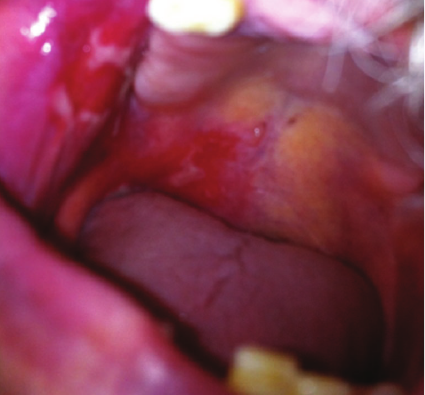
Figure 4: No response after topical and systemic treatment with corticosteroids and dapsone, with further involvement of the right hard palate mucosa.